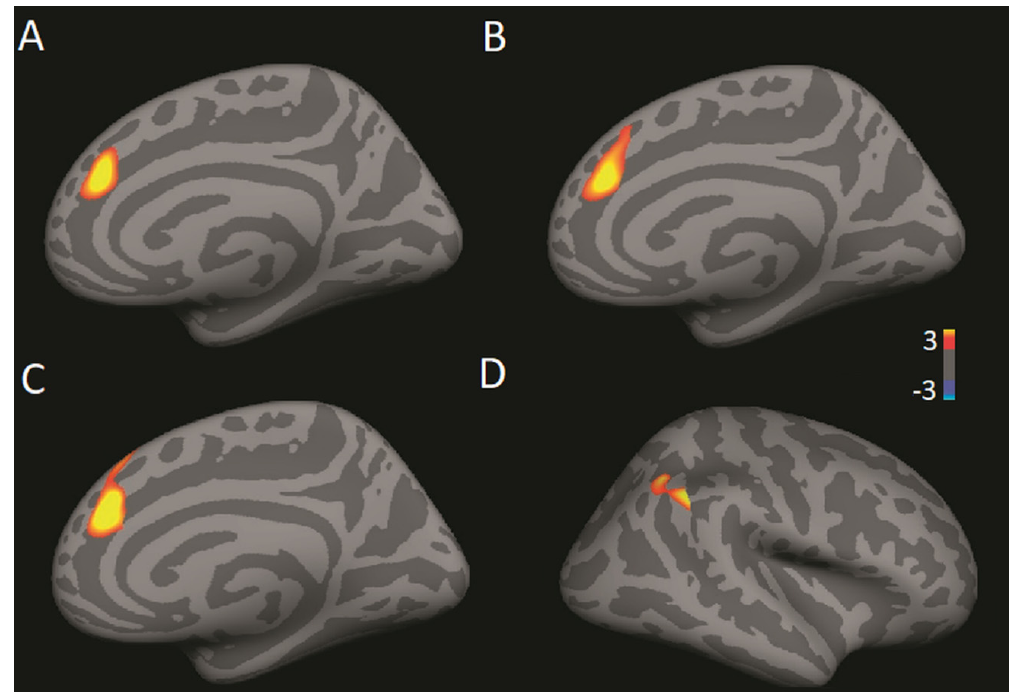
Figure 4. ( A ) Across all groups, there is a significant difference in the correlation between TWS and functional connectivity between the PCC/precuneus region and right ( p = 0.0384). ( B ) Comparing meditators vs. controls, there is a significant difference in the correlation between TWS and functional connectivity between the PCC/precuneus and the right dmPFC ( p = 0.0073). ( C ) Comparing yogis vs. controls, there is a significant difference in the correlation between TWS and functional connectivity between the PCC/precuneus and the right dmPFC ( p = 0.0045). ( D ) Comparing yogis vs. controls, there is a significant difference in the correlation between TWS and functional connectivity between the PCC/precuneus and the right TPJ ( p = 0.0319).